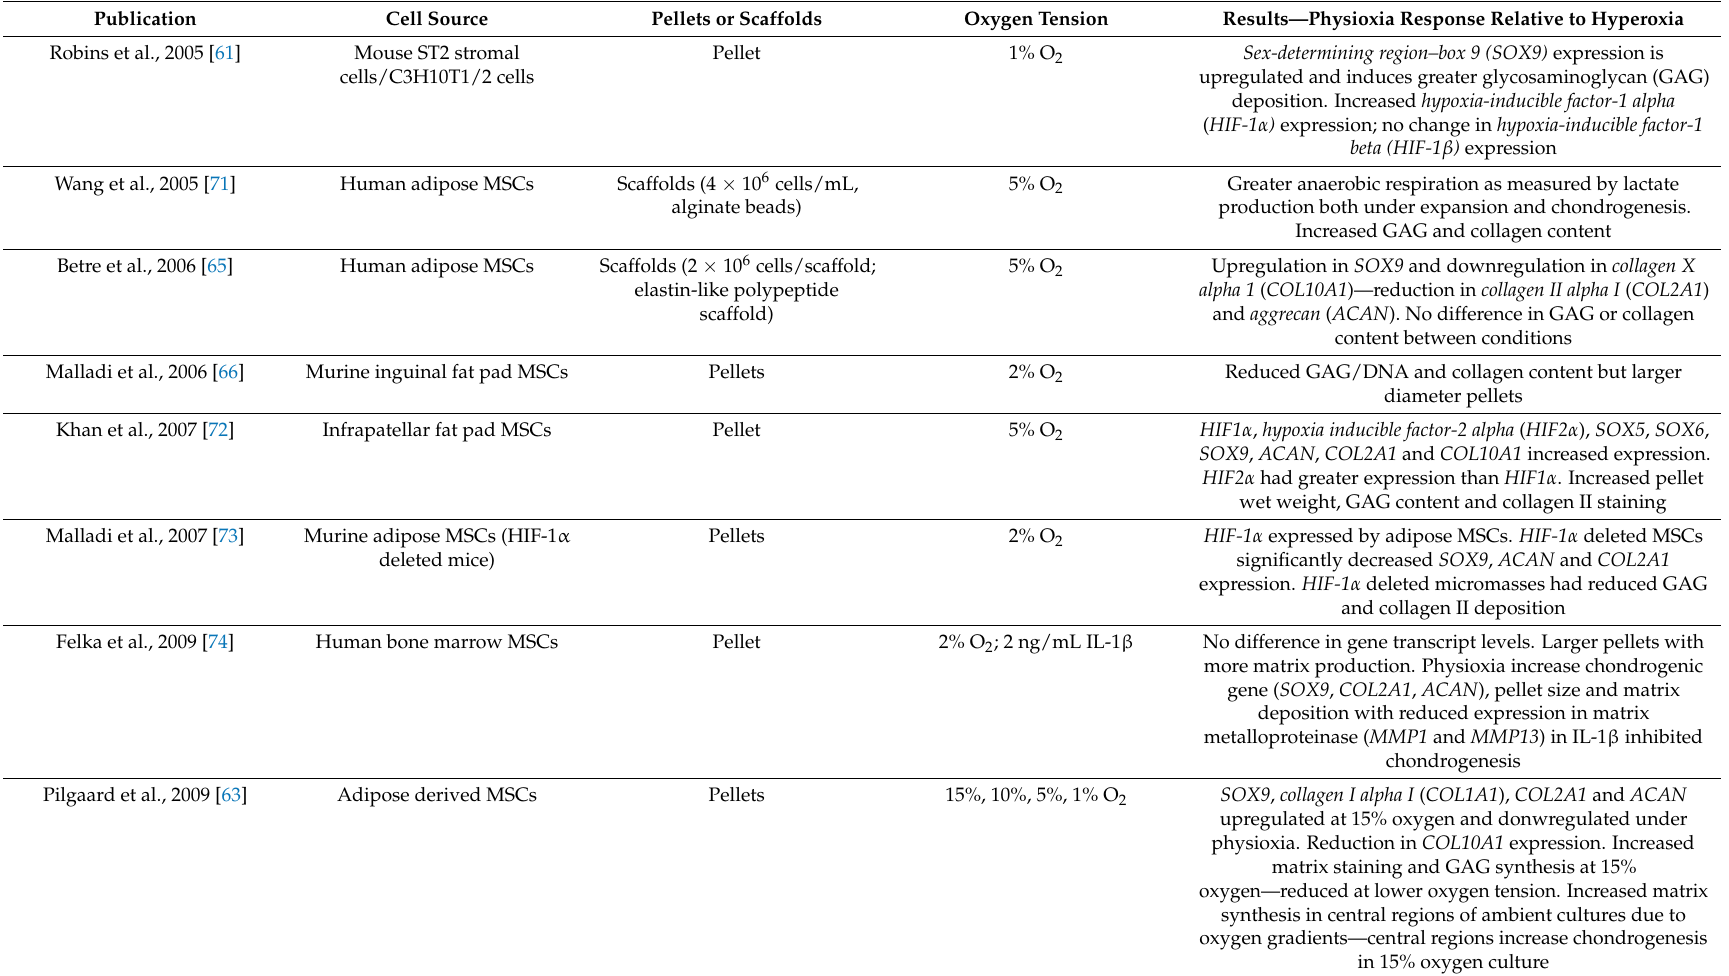
Table 1. Summary of the key findings from publications examining the effect of physioxia on mesenchymal stem cell (MSC) chondrogenesis. Findings are relative to